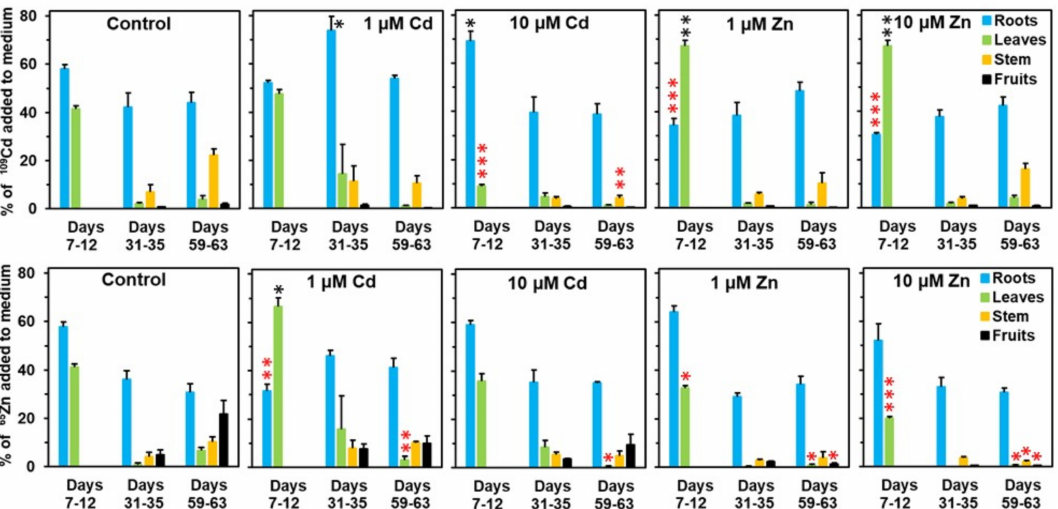
Figure 1. Influence of elevated concentrations in the nutrient medium on the distribution of 109 Cd and 65 Zn. Young plants (10 d old) were transferred at day 0 to the nutrient media with di ff erent cadmium and zinc concentrations. The labeling period is indicated below the diagrams: the first number indicates the beginning (addition of 109 Cd and 65 Zn to the nutrient media) and the second number the end (plant analysis) of the labeling phase. Means + SE of four replicates are shown. Significantly higher (*, **, ***) and lower (*, **, ***) values than in control plants on the P = 0.05 (*, *), P = 0.01 (**, **), and P = 0.001 (***, ***) level are indicated above the columns (Student’s